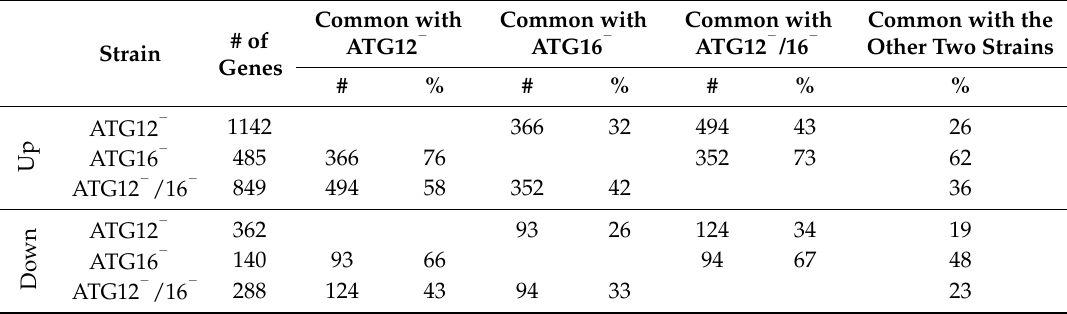
Table 3. Common differentially regulated genes of ATG12 − , ATG16 − , and ATG12 − /16 − cells. An absolute fold change of ≥ 2.0 and a p ≤ 0.05 was used for analysis. #, number. Common with Common with Common with Common with # of ATG12 − ATG16 − ATG12 − /16 − Strain Genes